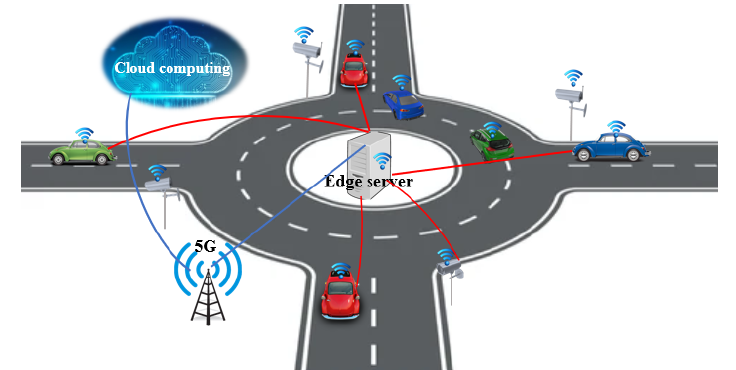
Figure 1. Cyber-physical roundabout